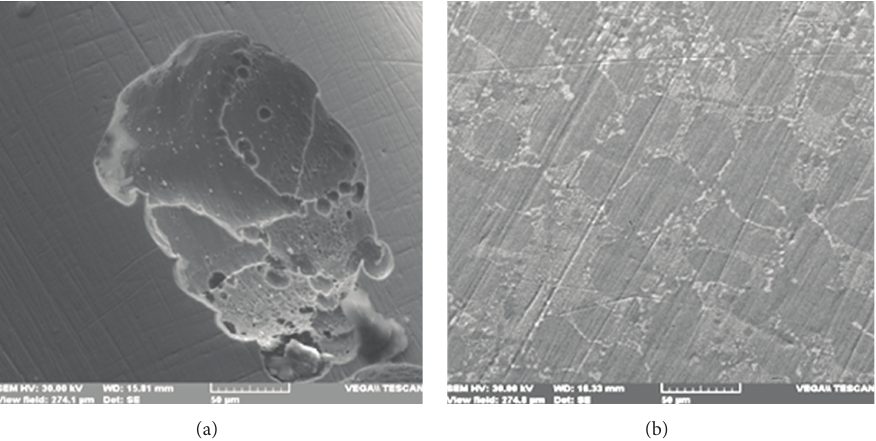
F 2: SEM images of corroded surfaces on (a) NiTi and (b) NiTiNb alloys aer anodic potentiodynamic polarization tests.